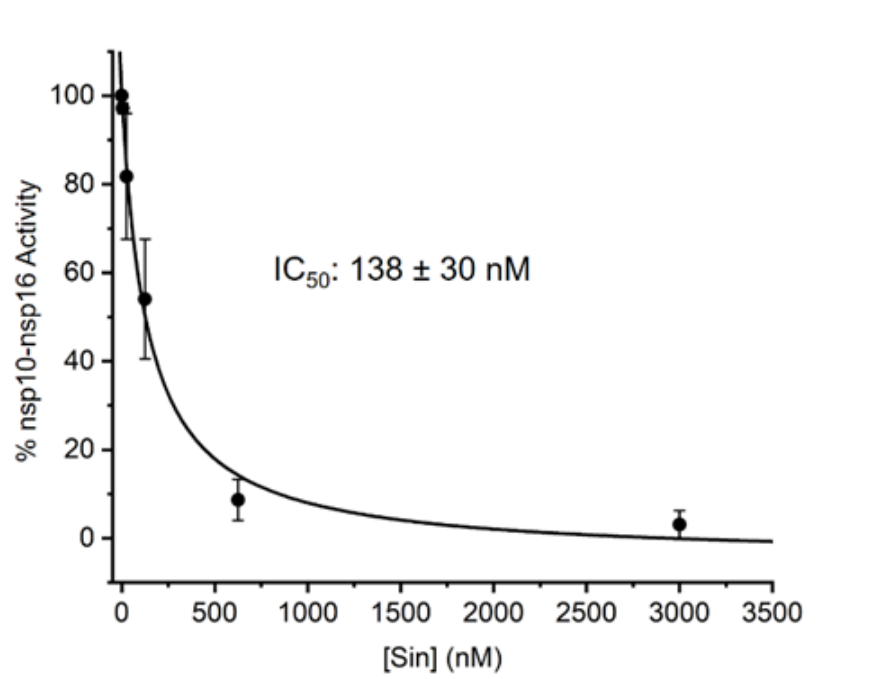
Figure 4. Inhibition curve of Sinefungin. Capped m 7 Gp 3 A-RNA was treated with nsp10-nsp16 and SAM at various concentrations of Sinefungin. After reaction, RNA was cleaved by nuclease P1 and analyzed, and the dimethylated cap (m 7 Gp 3 Am) was quantified by LC-MS. The measurement was performed in triplicate.